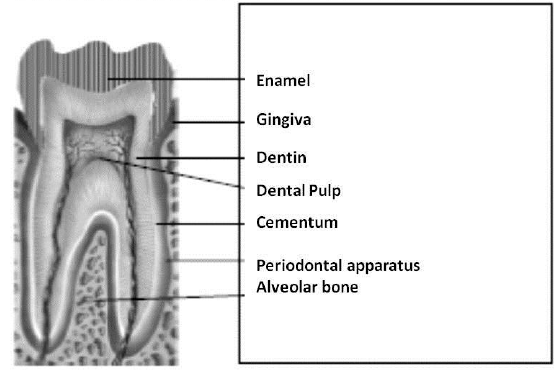
Figure 1. Schematic section of a tooth and surrounding tissues.